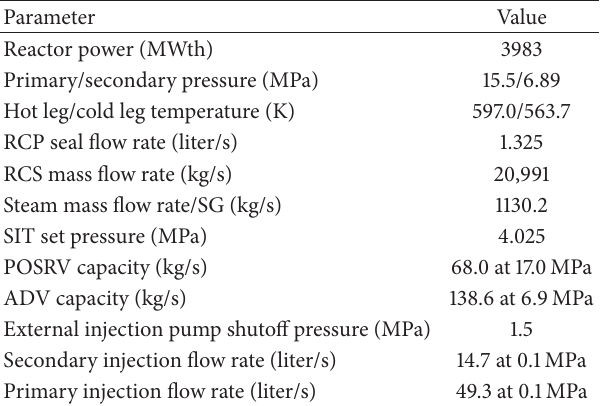
Table 2: Initial and boundary conditions.